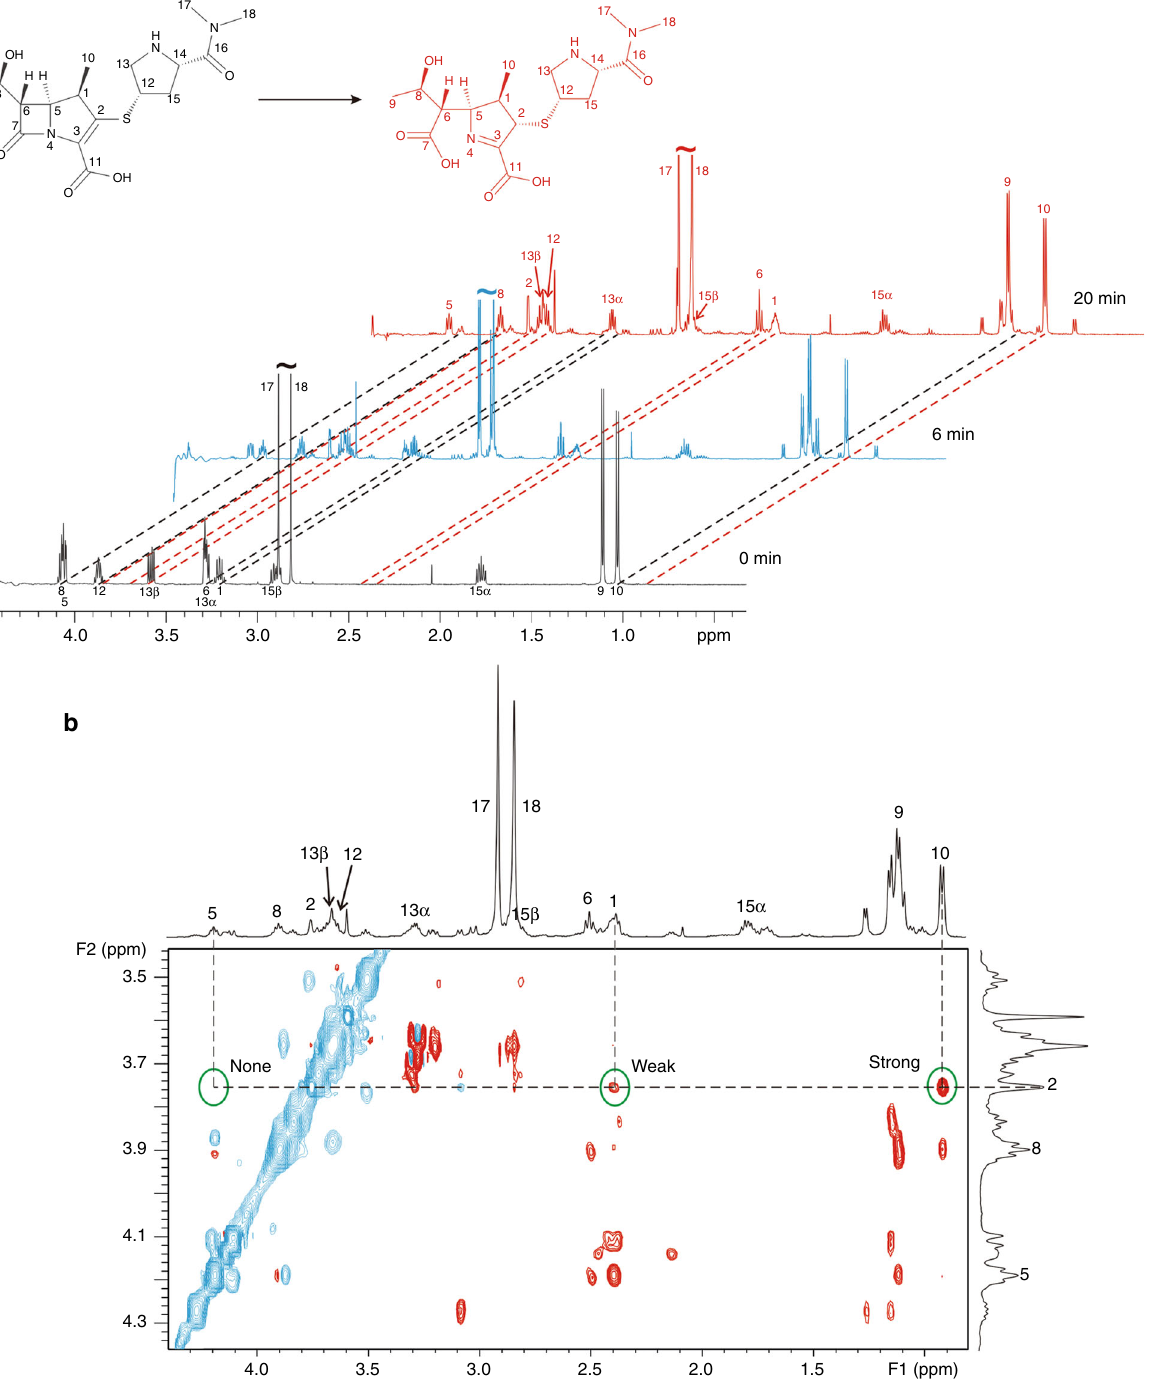
Fig. 4 NMR spectra monitoring meropenem hydrolysis catalyzed by NDM-1. a 1 H NMR spectrum of hydrolyzed meropenem recorded before and 6 or 20 min after NDM-1 addition to the reaction system. b Part of a ROESY spectrum of the hydrolysis product. Diagonal and cross peaks are shown in blue and red, respectively. Proton signal assignments are labeled beside the peaks. The chemical shifts of H2, H1, H5, and H10 are highlighted by dashed